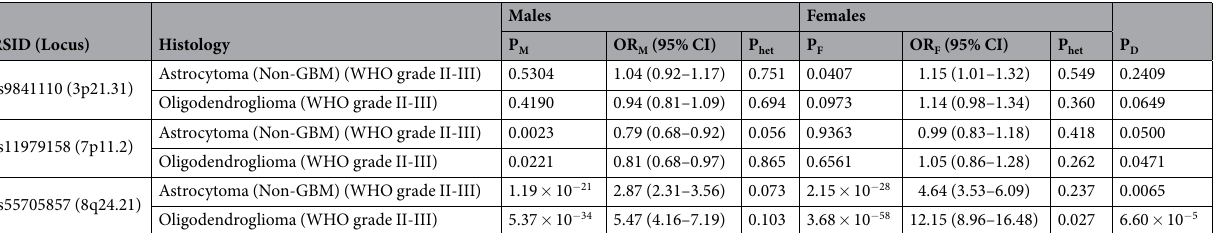
Table 3. Sex-specific odds ratios (OR), 95% confidence intervals (95% CI), and p values from meta-analysis